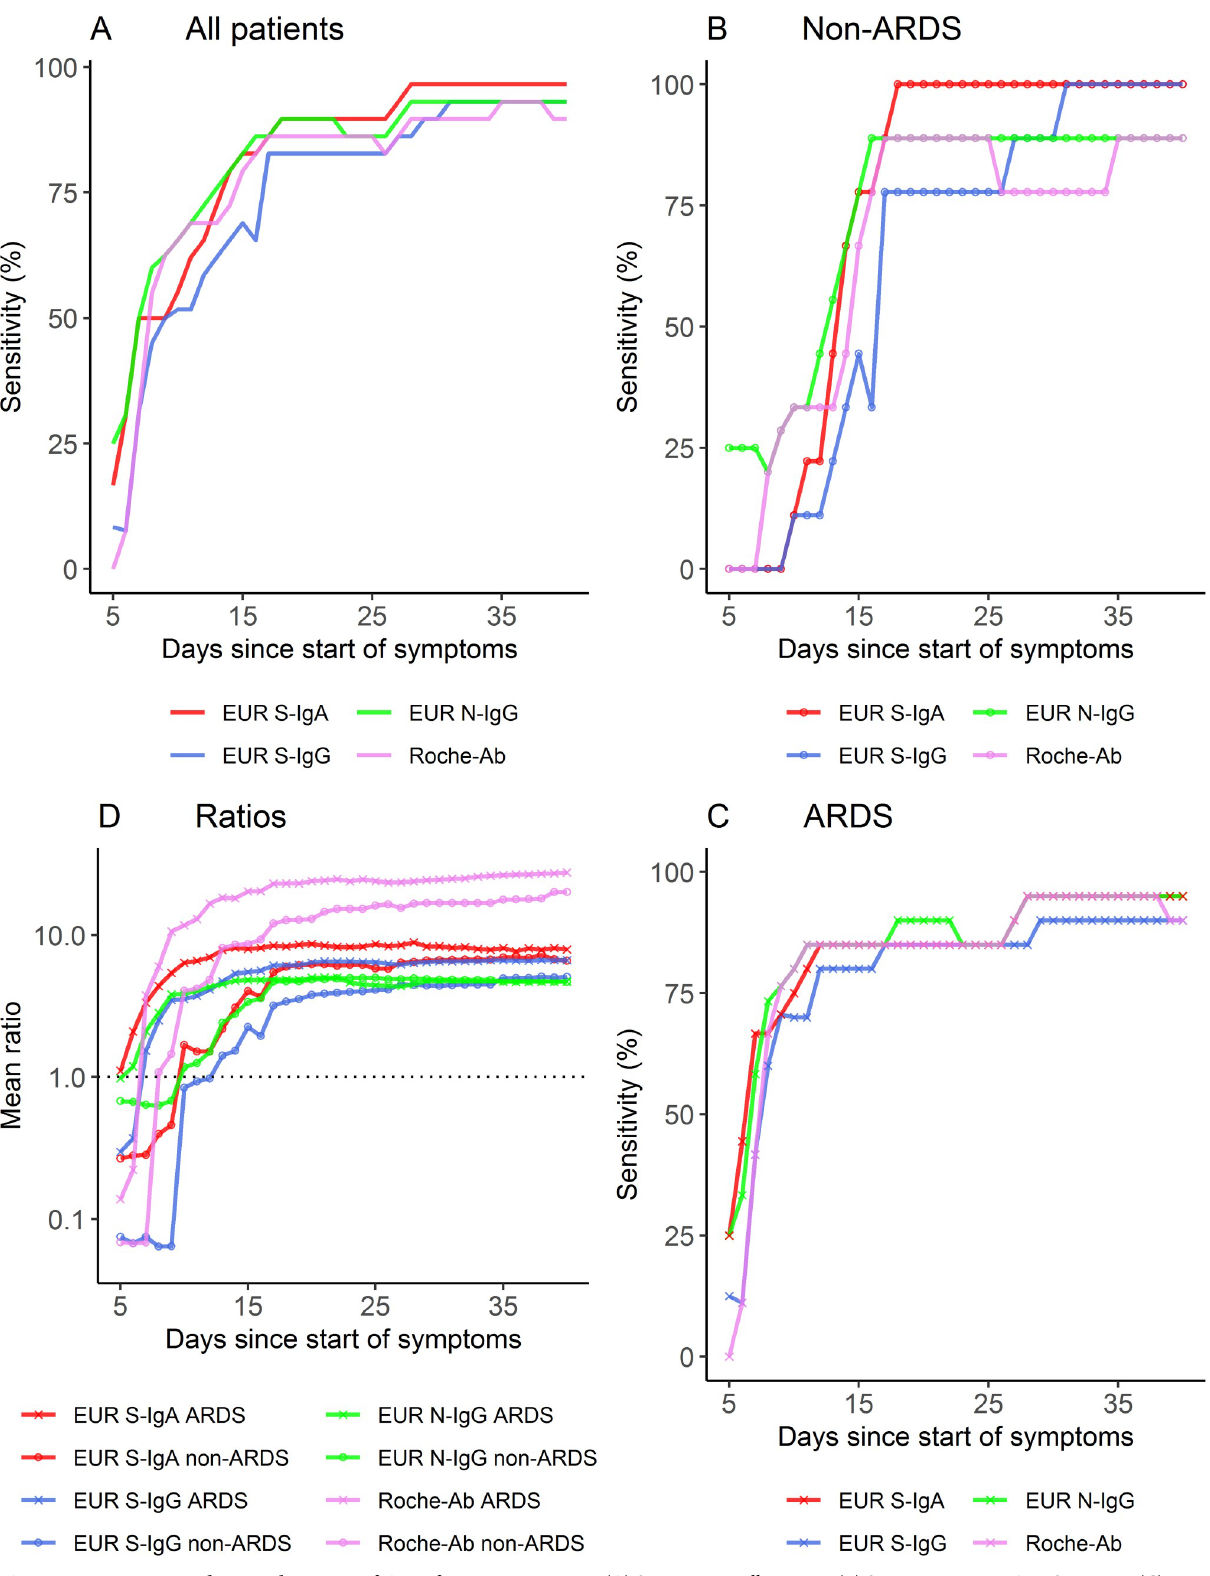
Fig 2. Immunoassay results over the course of time after symptom onset. (A) Sensitivity in all patients. (B) Sensitivity in non-ARDS patients. (C) Sensitivity in ARDS patients. (D) Mean signal ratios of the four immunoassays in non-ARDS patients and ARDS patients. https://doi.org/10.1371/journal.pone.0251587.g002 PLOS ONE | https://doi.org/10.1371/journal.pone.0251587 May 13,